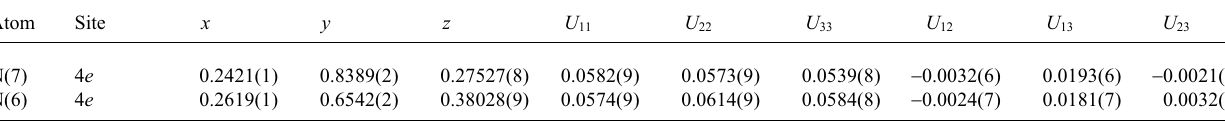
Table 3. Atomic coordinates and displacement parameters (in Å 2